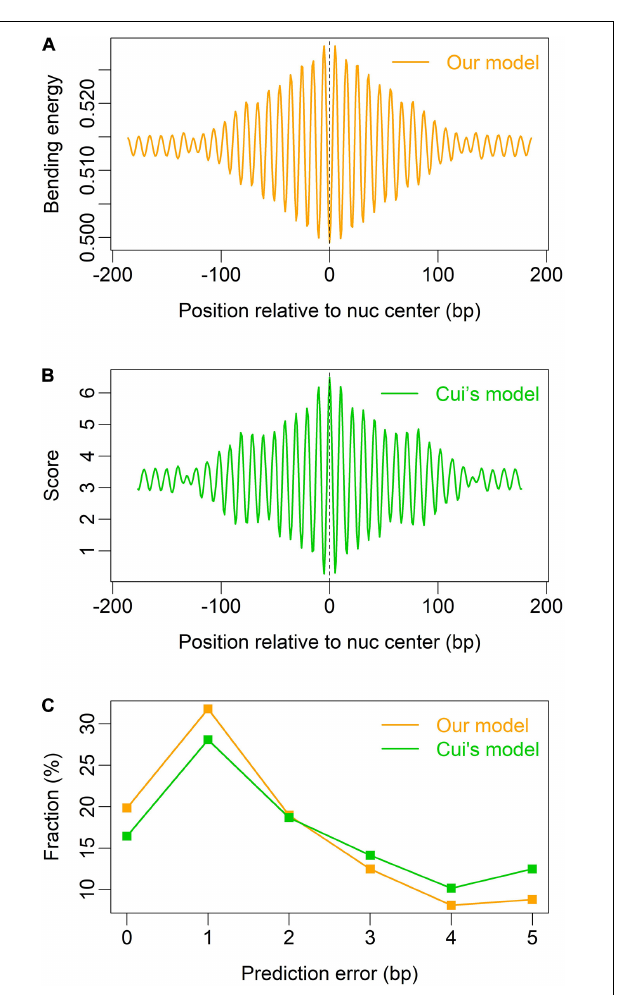
FIGURE 4 | Prediction of nucleosome dyad positions (or rotational positioning) in mouse embryonic stem cells. Non-overlapping nucleosomes with NCP score > 2 were analyzed (Voong et al., 2016). (A) Local bending energy minima coincide with the experimentally identified nucleosome dyad positions (Voong et al., 2016); (B) prediction based on W/S model (Cui et al., 2014); (C) comparison of prediction performance between the two